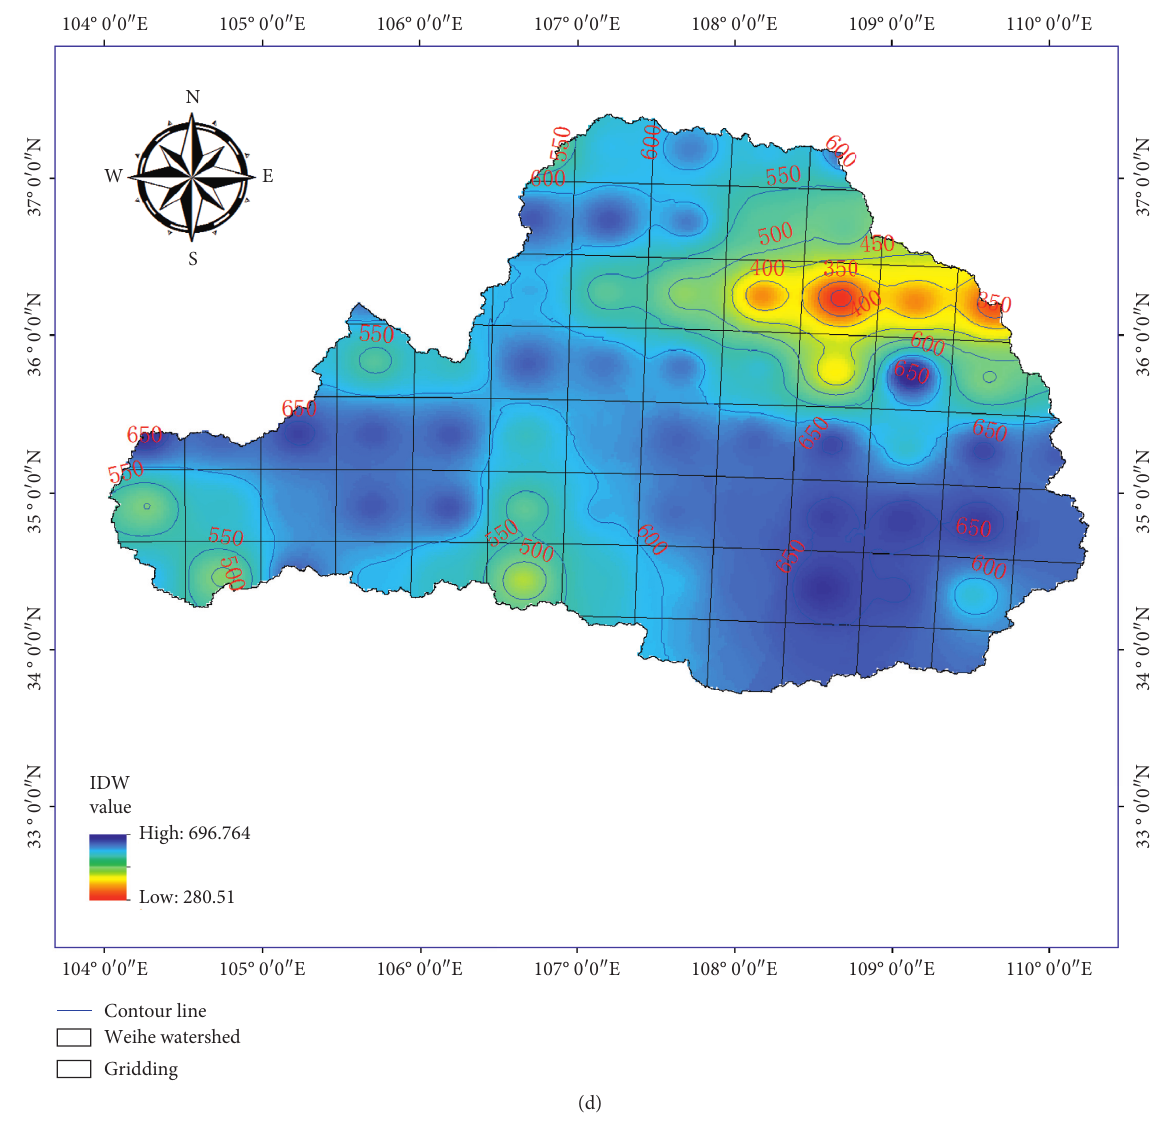
Figure 6: Soil moisture distribution in the Weihe Basin. (a) 70s, (b) 80s, (c) 90s, and (d)